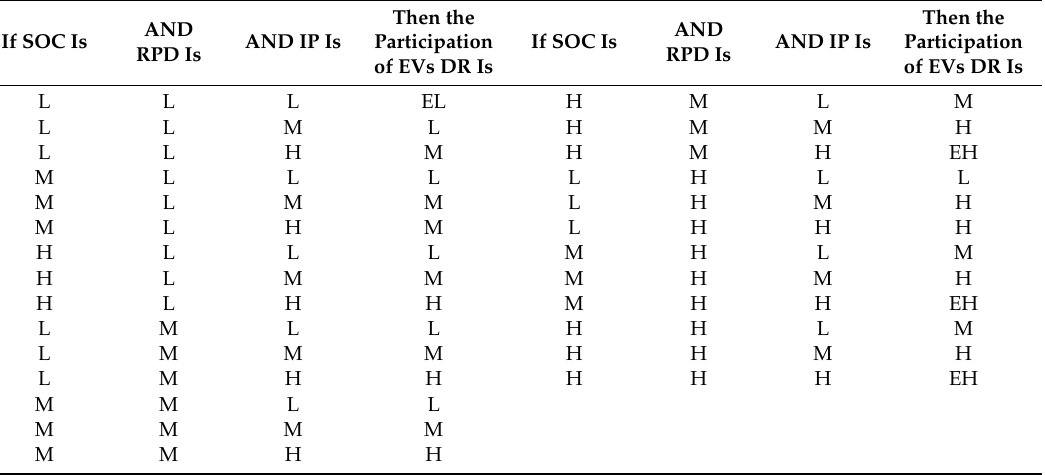
Table 3. Rule base and